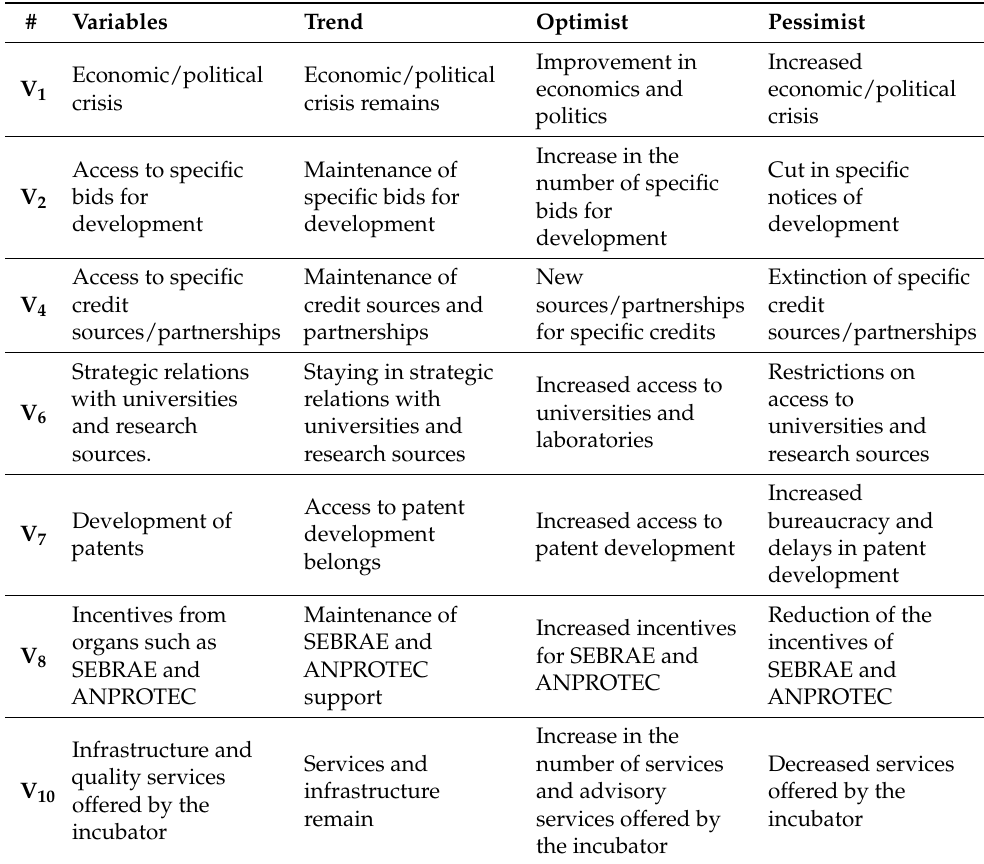
Table 10. Morphological analysis and scenario